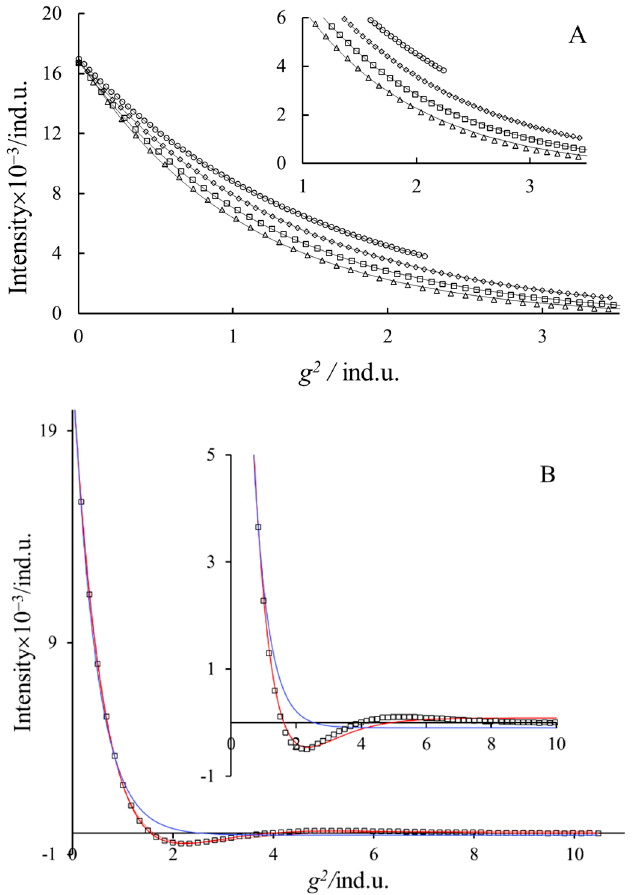
Figure 6. The decrease in the stimulated echo intensity with the increasing strength of the gradient square (0.07 mol kg − 1 NaDS, T = 319 K, δ = 4 ms). The inserts are the enlargements of the wrapped part of the curves. (A) The best fit of Equation (1) Δ = [circle = 20, diamond = 30, square = 40 and triangle = 50 ms] (B) Δ = 120 ms. The blue and red lines are the best fits of Equations (1) and (3), respectively.